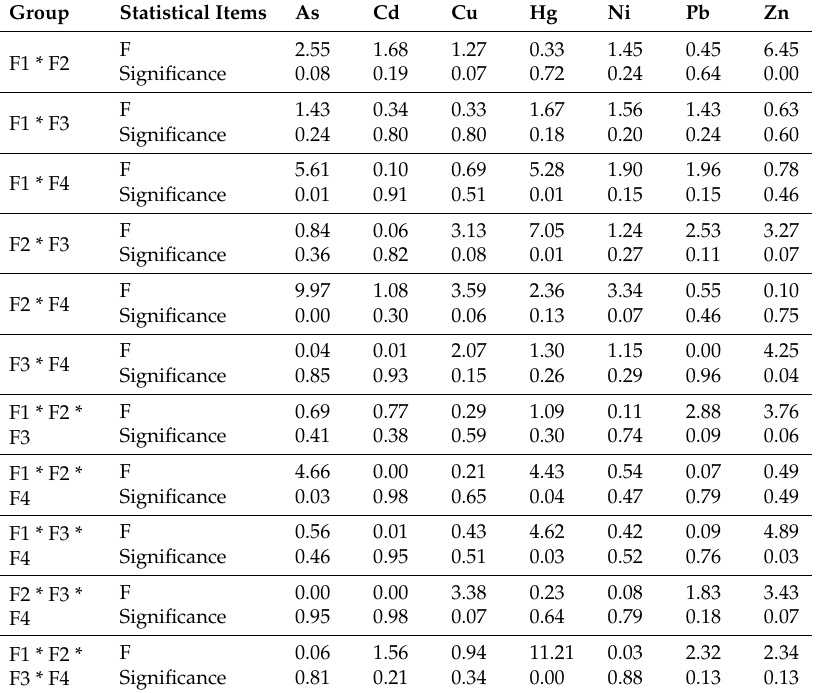
Table 5. Multivariate ANOVA results for heavy metals in agricultural soils. Group Statistical Items As Cd